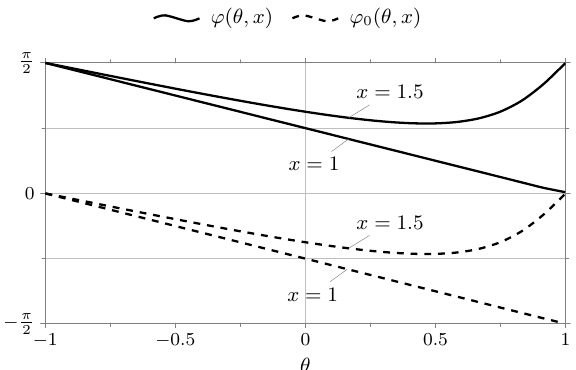
Figure 5. The graph of the function ϕ ( θ , x ) and ϕ 0 ( θ , x ) depending on the parameter θ in the case of x (cid:62) 1 (The graphs are plotted for x = 1.5 and x =